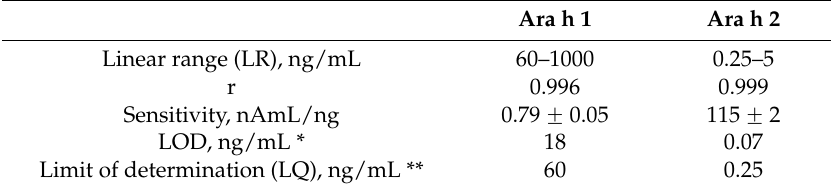
Figure 3. Calibration plots obtained with the dual immunosensing platform for Ara h 1 and Ara h 2 standards. Error bars estimated as triple of the standard deviation ( n = 3). Table 1. Analytical characteristics for the determination of Ara h 1 and Ara h 2 using the dual magnetic beads (MBs)-based immunosensing platform.